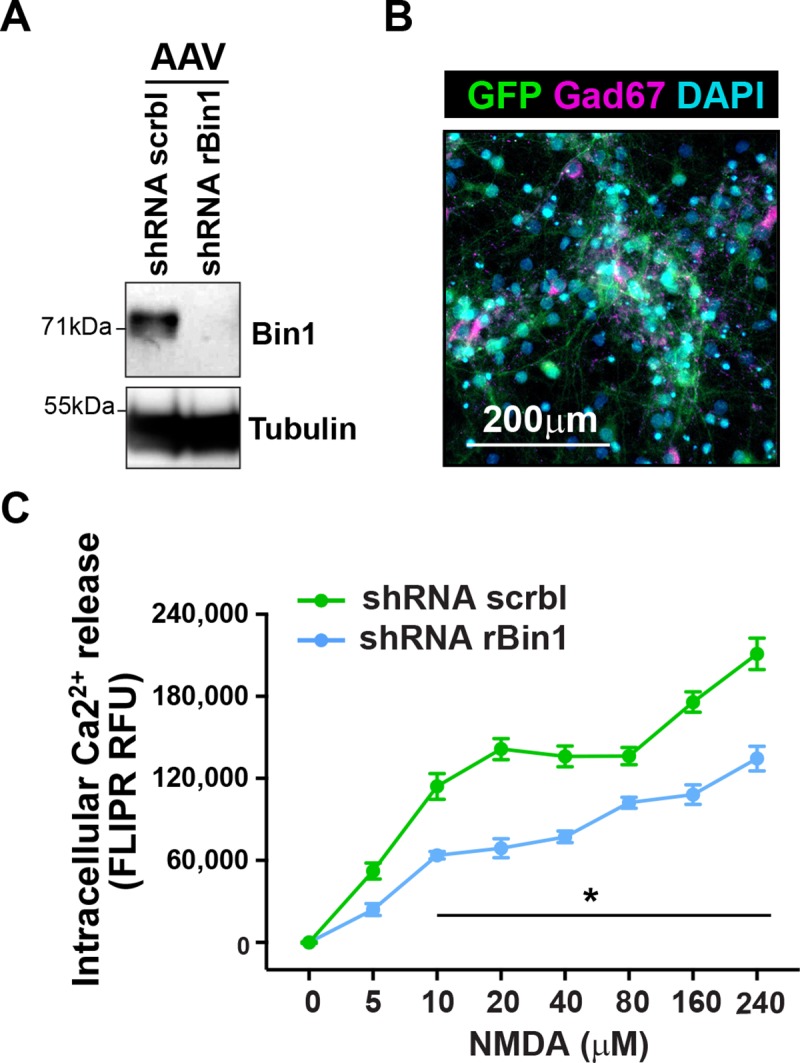
Acute knockdown of Bin1 reduces neuronal activity in vitro.(A) Western blot image showing Bin1 levels in lysates from cultured rat cortical neurons infected with AAV-GFP-U6-shRNA-scramble (control) and AAV-GFP-U6-shRNA-rBin1 (shRNA targeting rat Bin1). Representative image from three independent biological replicates. (B) Representative image of cultured rat cortical neurons on DIV 14 stained for GFP, Gad67 (inhibitory cell marker) and DAPI. Scale bar: 200μm. (C) Plot representing intracellular Ca2+ release, as measured by FLIPR Relative Fluorescence Unit (RFU), in cultured rat cortical neurons infected with AAV-GFP-U6-shRNA-scramble and AAV-GFP-U6-shRNA-rBin1, respectively. FLIPR RFU represents the mean area under curve for fluorescence readings post-NMDA addition. Plot shows one representative experiment out of four independent biological replicates. Each point represents the mean ± SD of 6 wells per condition. Two-way ANOVA with Tukey’s multiple comparison test: p-value: * p< 0.05; ** <0.01; *** p<0.001.